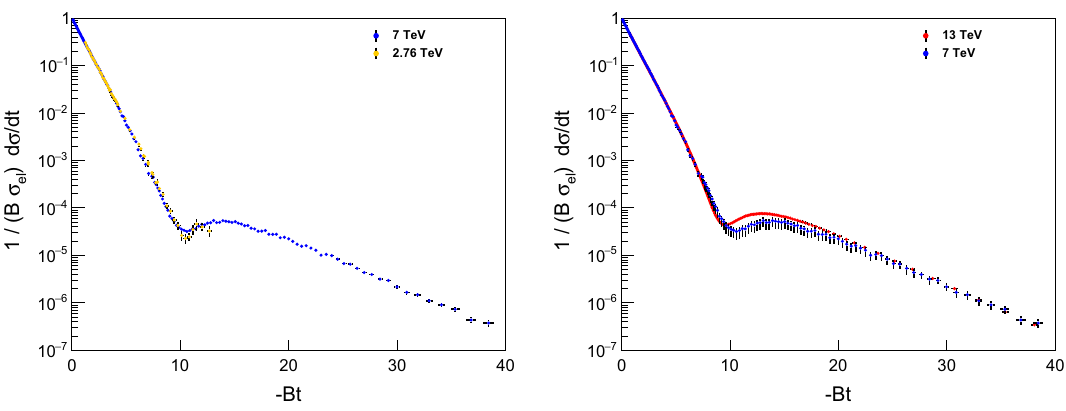
Fig. 2 Scaling behaviour of the differential cross section d σ/ dt of added in quadrature. The left panel indicates, that the H ( x ) scaling is √ s = 2 . 76 and 7 . 0 TeV, so the within statistical errors valid between elastic pp collisions at LHC energies. Elastic scattering data are mea- √ √ s = 13TeV[1],at s = 7TeV H ( x ) scaling works from 7 TeV downwards. The right panel indicates suredbytheTOTEMCollaborationat √ s = 2 . 76 TeV [4]. Left panel shows the 2 . 76 and 7 TeV [28], and at that the H ( x ) scaling is violated, when the colliding energy is increased √ s = 7 . 0 to 13 TeV: the right panel indicates scaling violations data points with statistical errors only, while the right panel shows the from 7 . 0 and 13 . 0 TeV data with statistical and t -dependent systematic errors that go well beyond the combined statistical and systematic errors